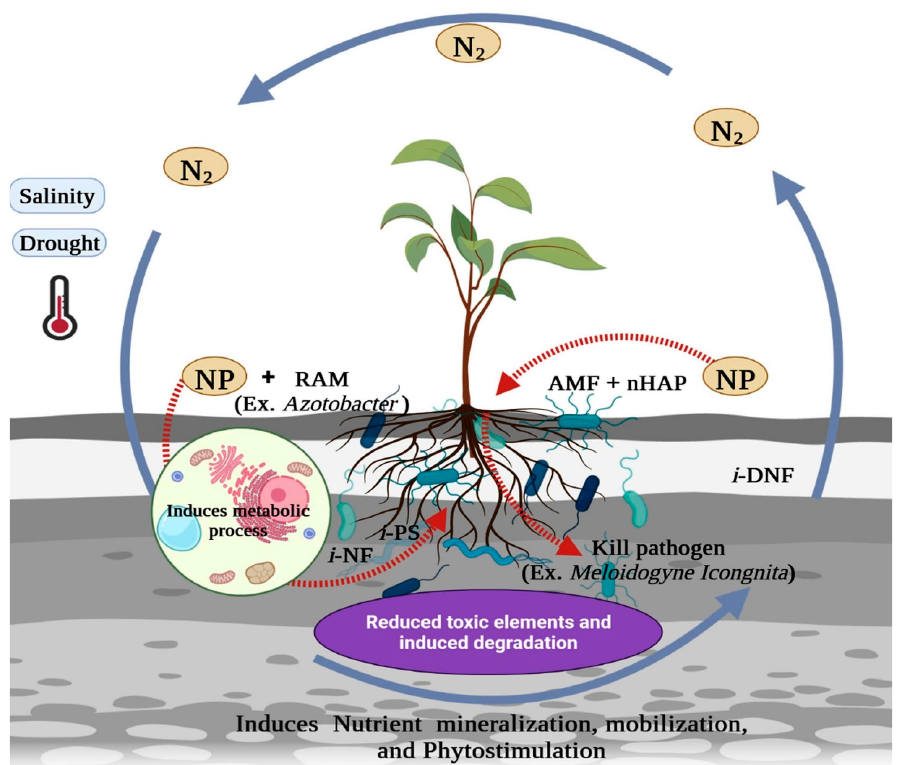
Figure 1. Plant growth is induced through nanotechnology under adverse soil conditions by enhancing root-associated microbe functionalities and improving nutrient cycling and the phytostimulation process. i -PS (Induced phosphate solubilization, i -NF (Induced Nitrification), i -DNF (Induced Deni- trification), NP (Nanoparticles), RAM (Root Associated Microbes), AMF (Arabuscular Mycorrhiza), and nHAP (Hydroxyapatite